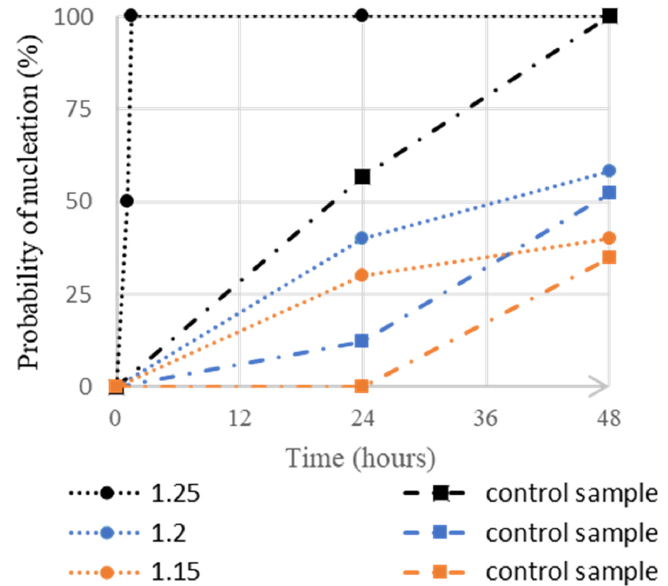
Figure 2. Evolution of the experimental probability of nucleation after laser irradiation over time (in hours) for different supersaturations: (a) β = 1.25; (b) β = 1.20; (c) β = 1.15. All samples were exposed to 1 pulse at 18 mJ (12MW.cm − 2 ) (circles ● ). Control samples were not exposed to laser; they nucleated spontaneously (squares ■ ). The dashed lines guide the eyes.